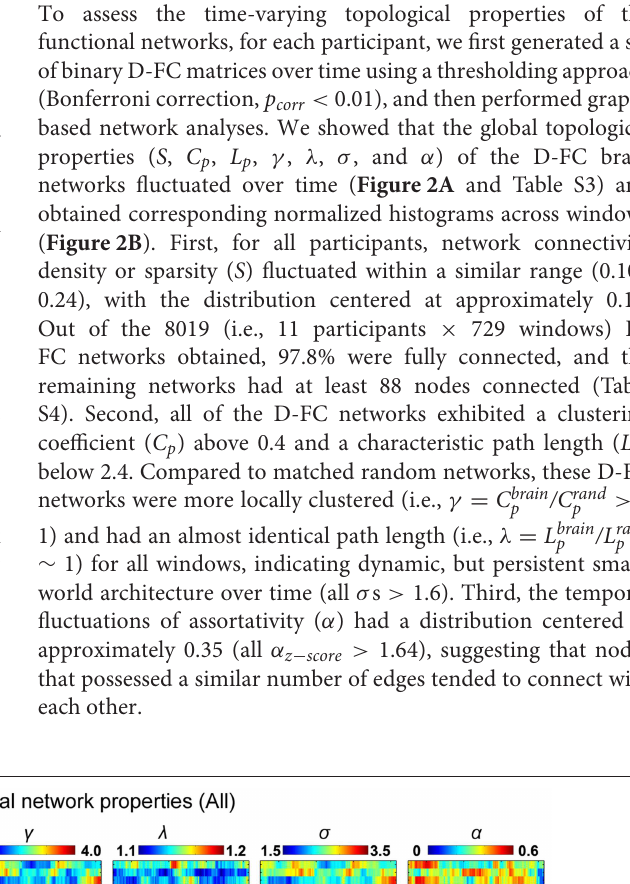
Frontiers in Human Neuroscience |